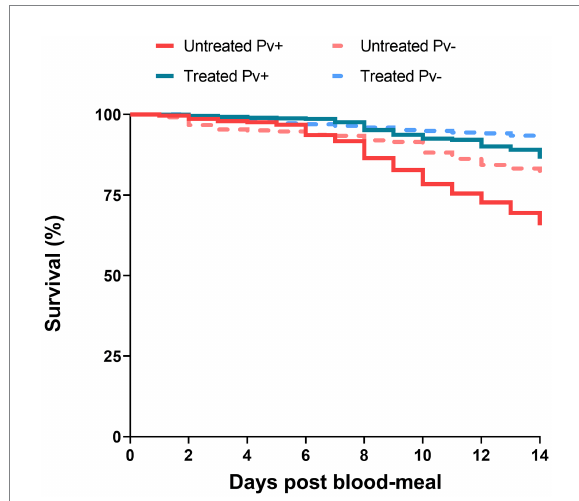
FIGURE 5 Survival curves of mosquitoes untreated and treated with antibiotics and fed on Plasmodium vivax positive samples (Pv + ) or on uninfected blood samples (Pv − ). Data are pooled from nine independent experiments with P. vivax positive groups (Pv + ) and five independent experiments with uninfected groups (Pv − ). Mosquitoes ( n ~ 100) per experiment and per condition.